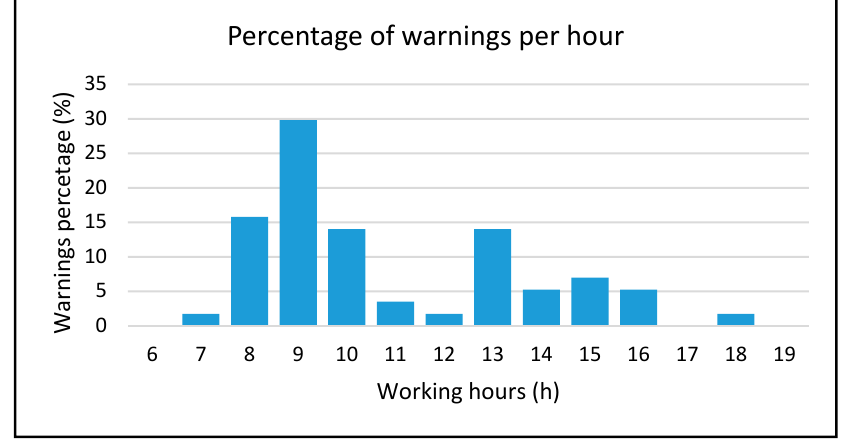
Figure 15. Percentage of warnings detected per hour.